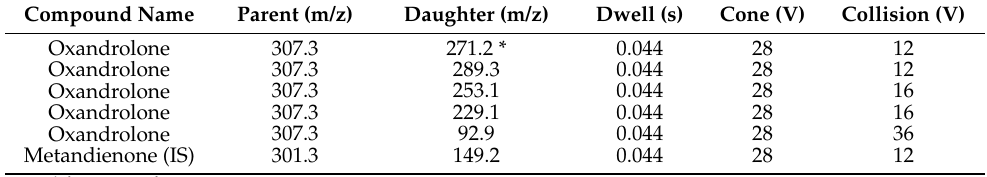
Table 1. The MS conditions for oxandrolone and methandienone in SRM